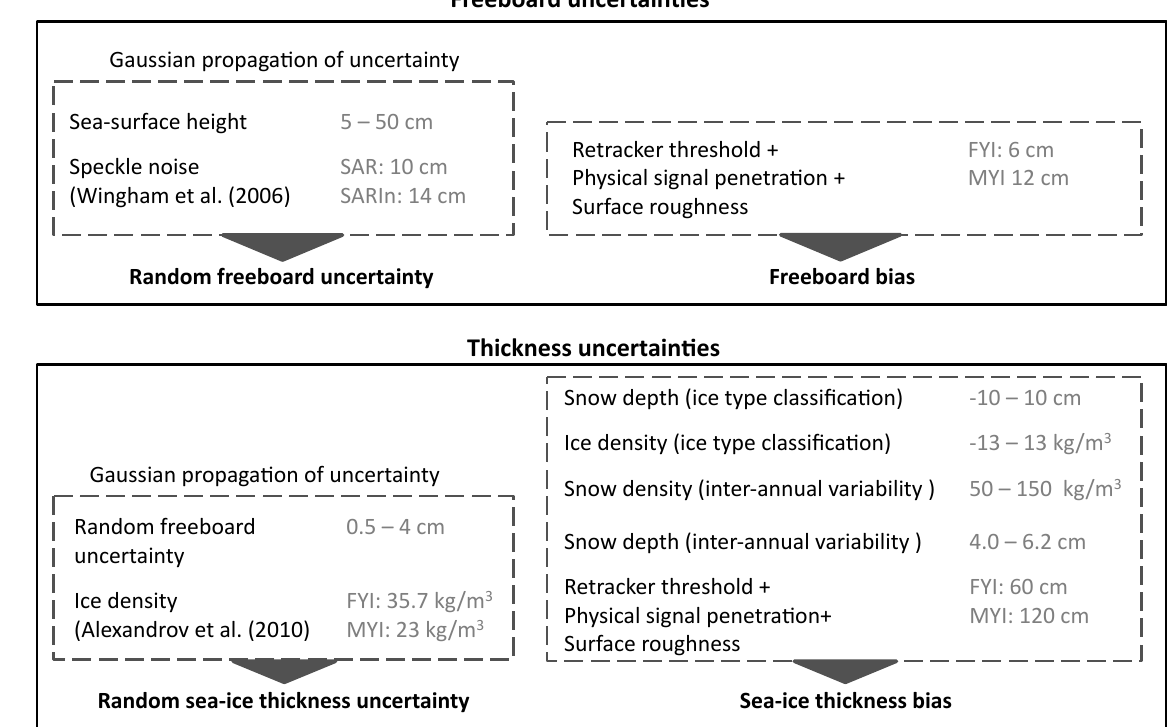
Figure 4. Flowchart of the CryoSat-2 uncertainty budget for freeboard and thickness, showing the typical range for the individual uncertainty of each parameter and referring to a single CryoSat-2